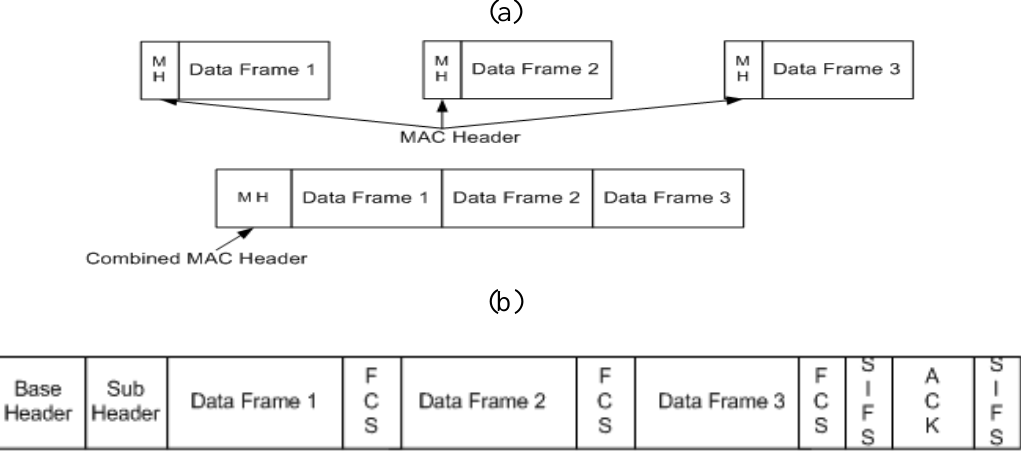
Figure 4. Aggregation Method and K-Dly-ACK-AGG Policy. (a) Aggregation Method; (b) K-Dly-ACK-AGG Policy (K =